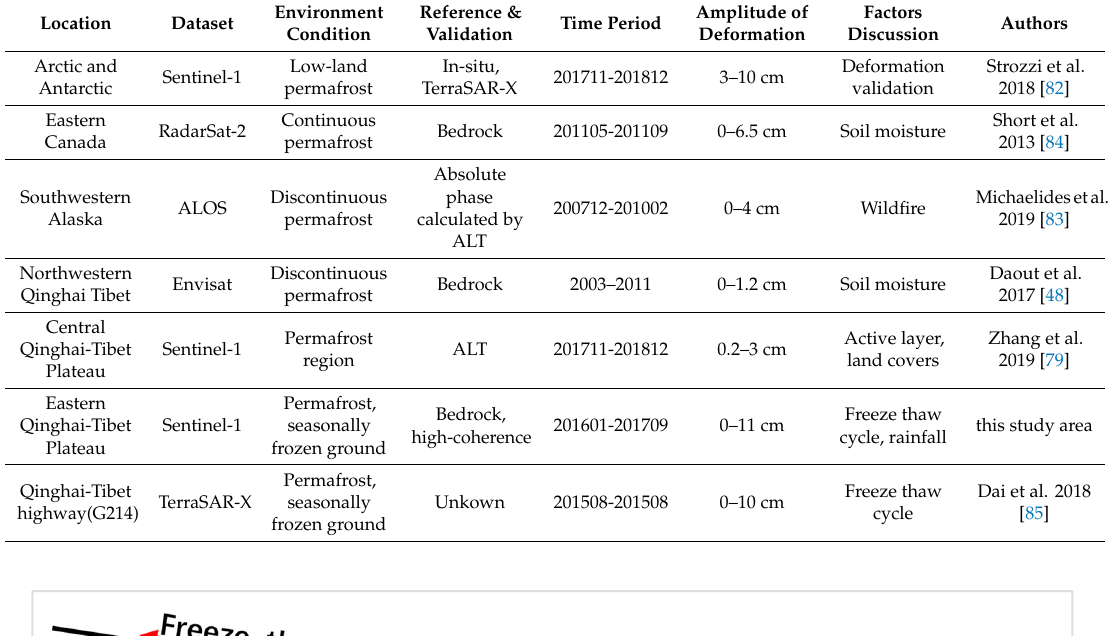
Table 2. Parameters of previous studies in global frozen ground region using SAR satellite.